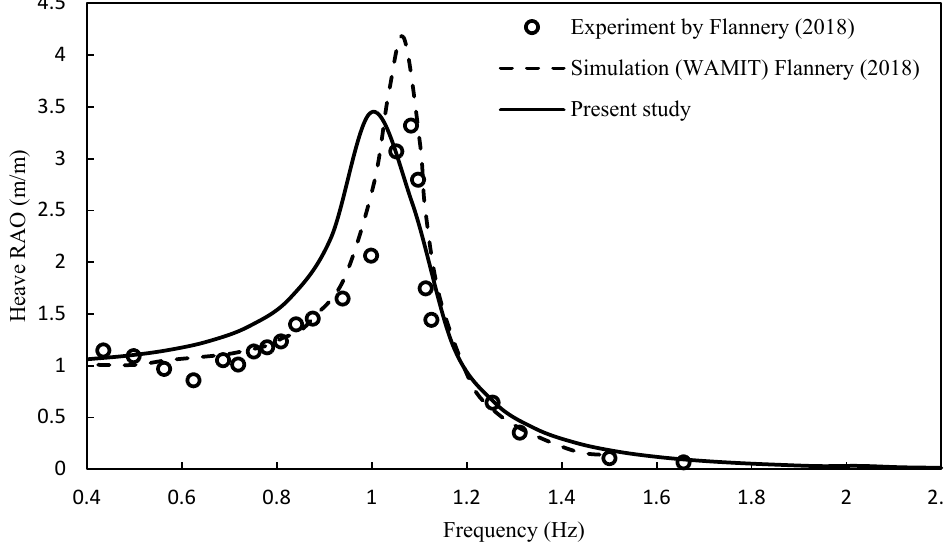
Figure 10. Heave RAO of the PA [26].